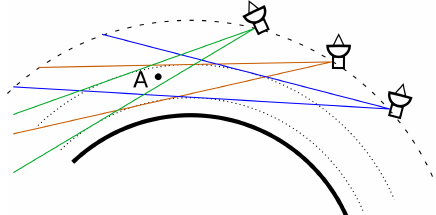
Figure 8. The principle of 2-D tomography. The field of view of the satellite within the orbital plane is shown for different satellite positions along the orbit. A point A inside the airglow layer lies within the field of view for all three positions, and therefore airglow radiance at point A contributes to observed radiances at all these po- sitions and every position in between. We can use the observations to solve for airglow radiance at point A (and all other such points) using inverse modeling.